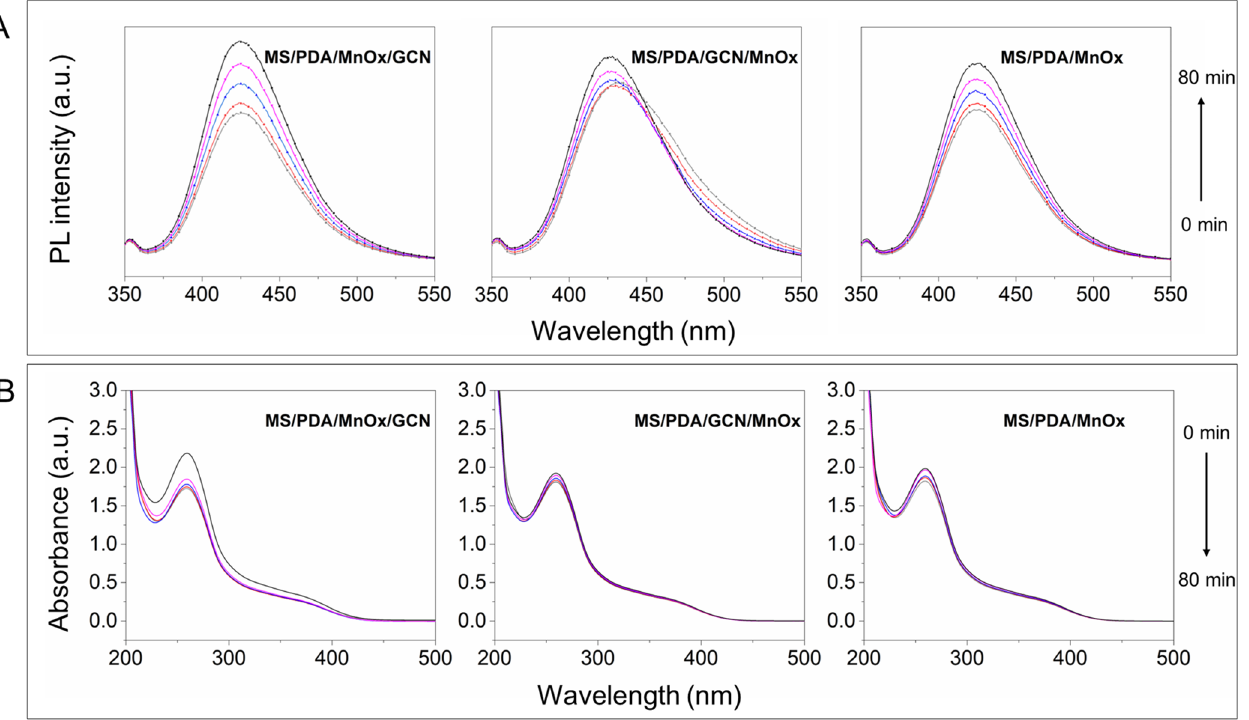
Figure 6. PL spectra of TA solution ( A ) and absorption spectra of NBT solution ( B ) with the catalysts MS/PDA/MnOx/GCN, MS/PDA/GCN/MnOx and MS/PDA/MnOx under xenon light irradiation.